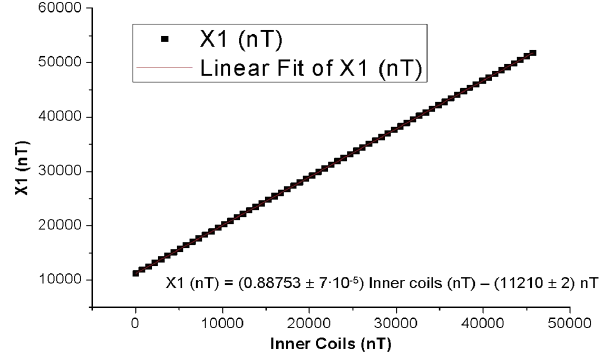
Figure 10. Data for Sensor 1 x axis “Ramp I” at 16.41 ◦ C